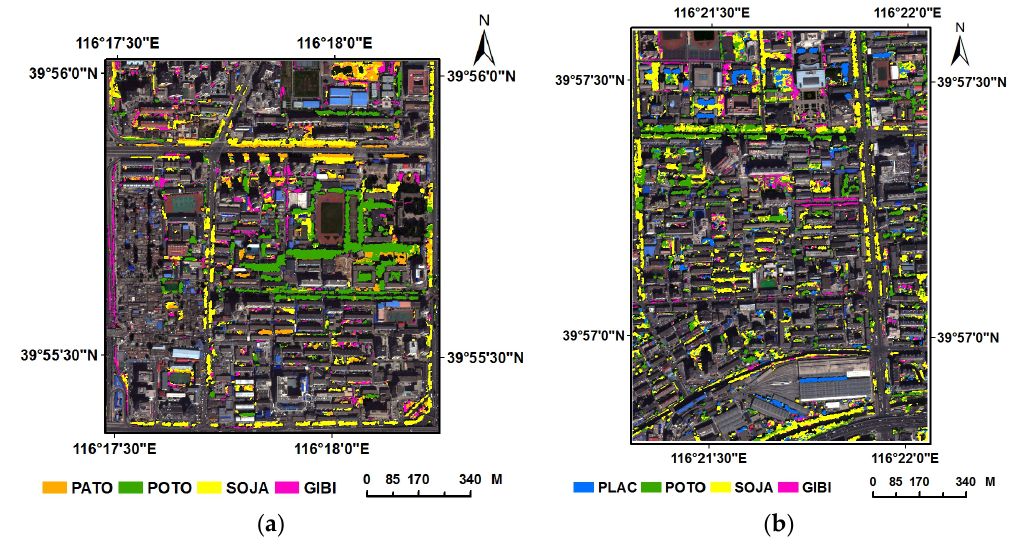
Figure 6. Tree species map at ( a ) CNU area and ( b ) BNU area using bi-temporal images and SVM method.